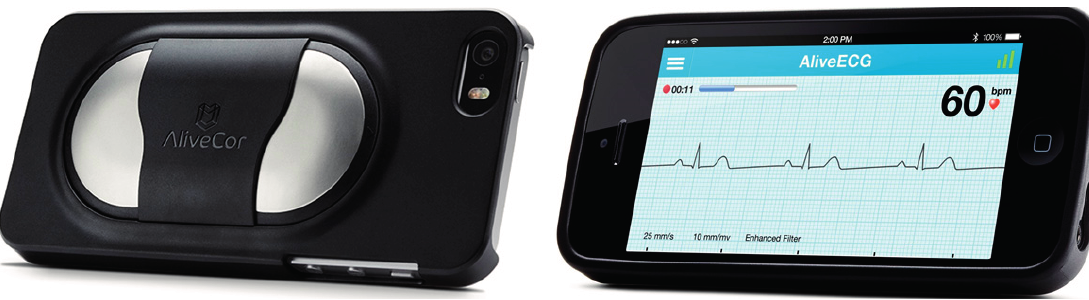
Figure 2. AliveCor Heart Monitor. Images provided by Rebecca Phillips, AliveCor